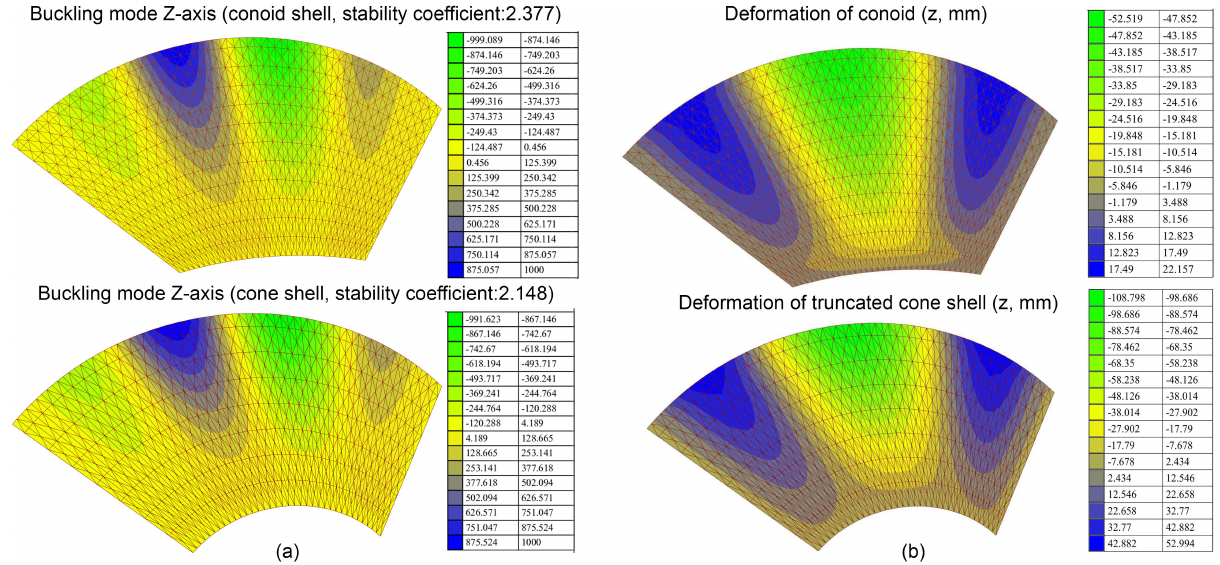
Figure 9: The buckling mode Z-axis (a) and deformation (b) of shells